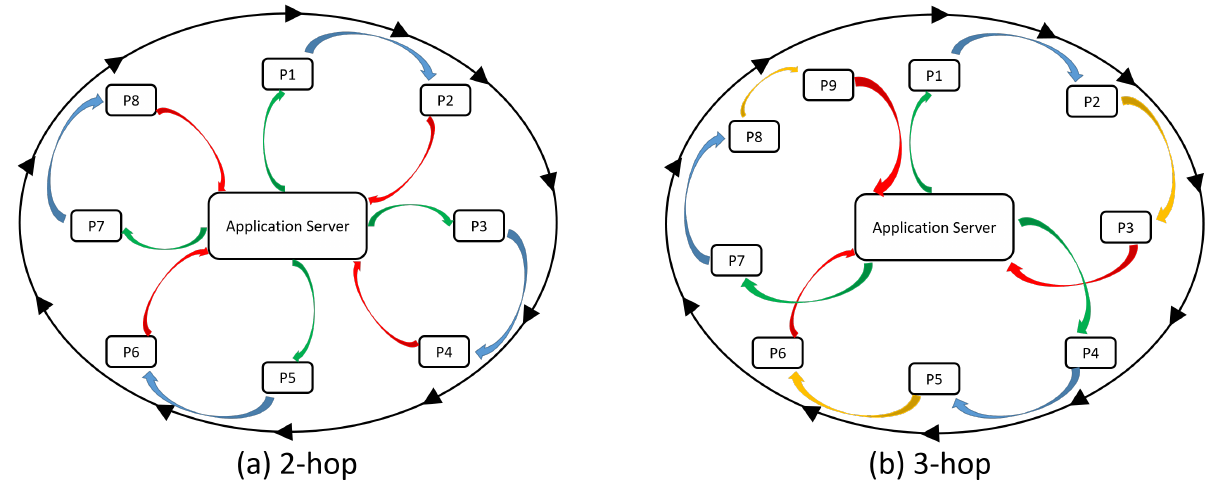
Figure 2: 2-hop and 3-hop examples of generalized m-hop modification